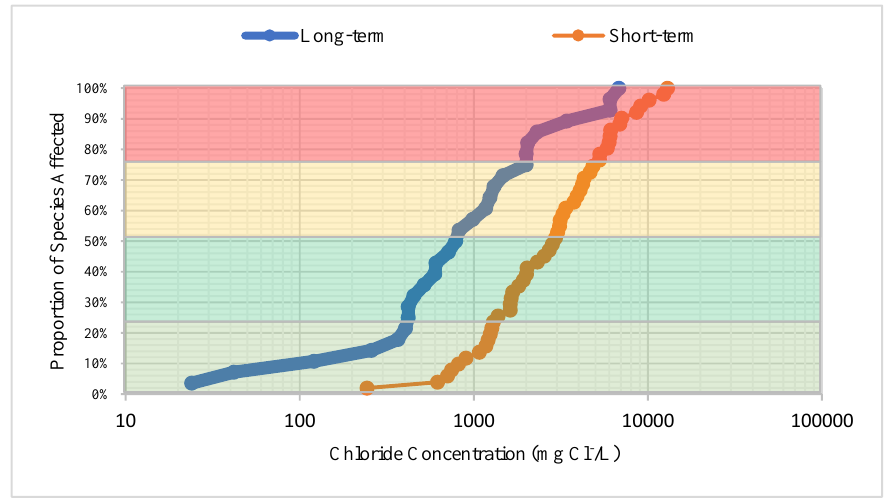
Figure 1. Chloride concentration for species exposed to chloride in freshwater [15].